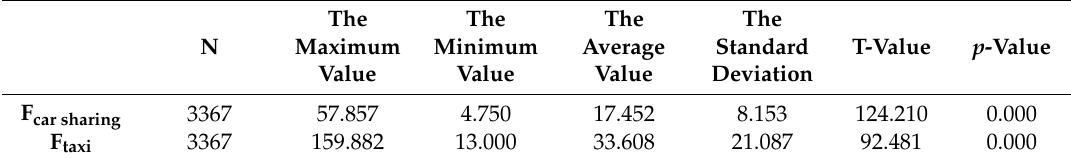
Table A3. The result of the single sample